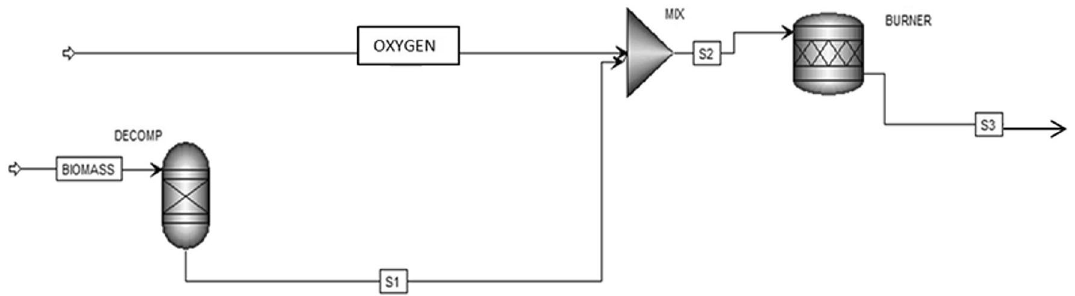
Figure 3. Flowchart of the plant evaluated in this study.